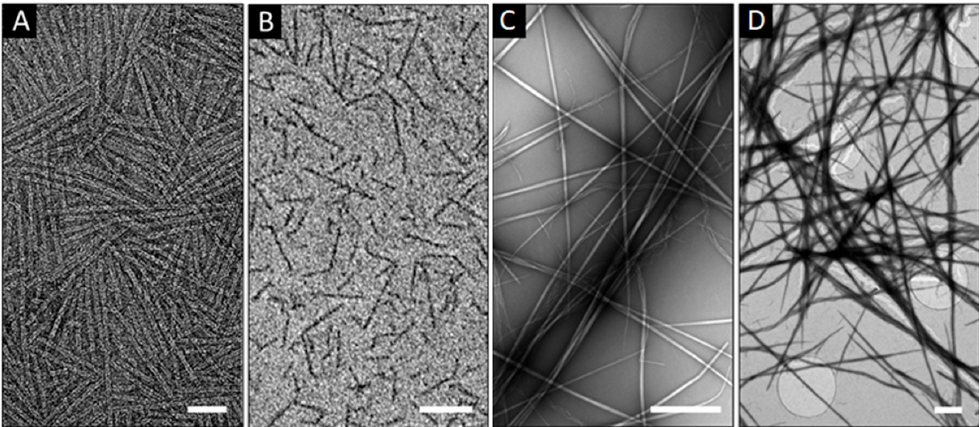
Figure 2. Staining patterns for filamentous protein assemblies. Electron micrograph of negatively stained model 3 ( A ) on silicon nitride TEM window, with staining variations that appear positive ( B ) on carbon film on copper grids ( B ). Electron micrographs of model 4, negatively stained on copper grids coated with Formvar and carbon films ( C ) and positively stained on Quantifoil ® gold grids coated with a single graphene layer ( D ). Scale bars are 50 nm ( A , B ) and 1 μ m ( C , D ). Staining conditions: uranyl acetate (aq. 2%, w/v).